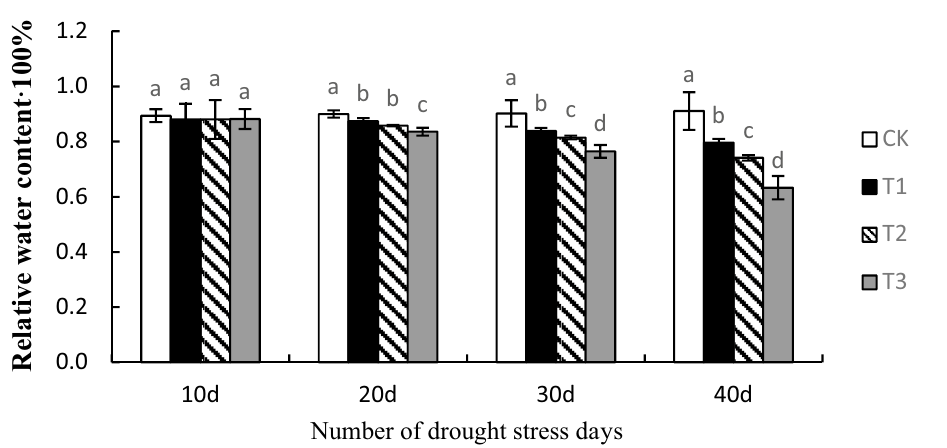
Figure 1. Effects of drought stress on the relative water content of Phedimus aizoon L. leaves. Note : The small letters mean significant differences at the P < 0.05